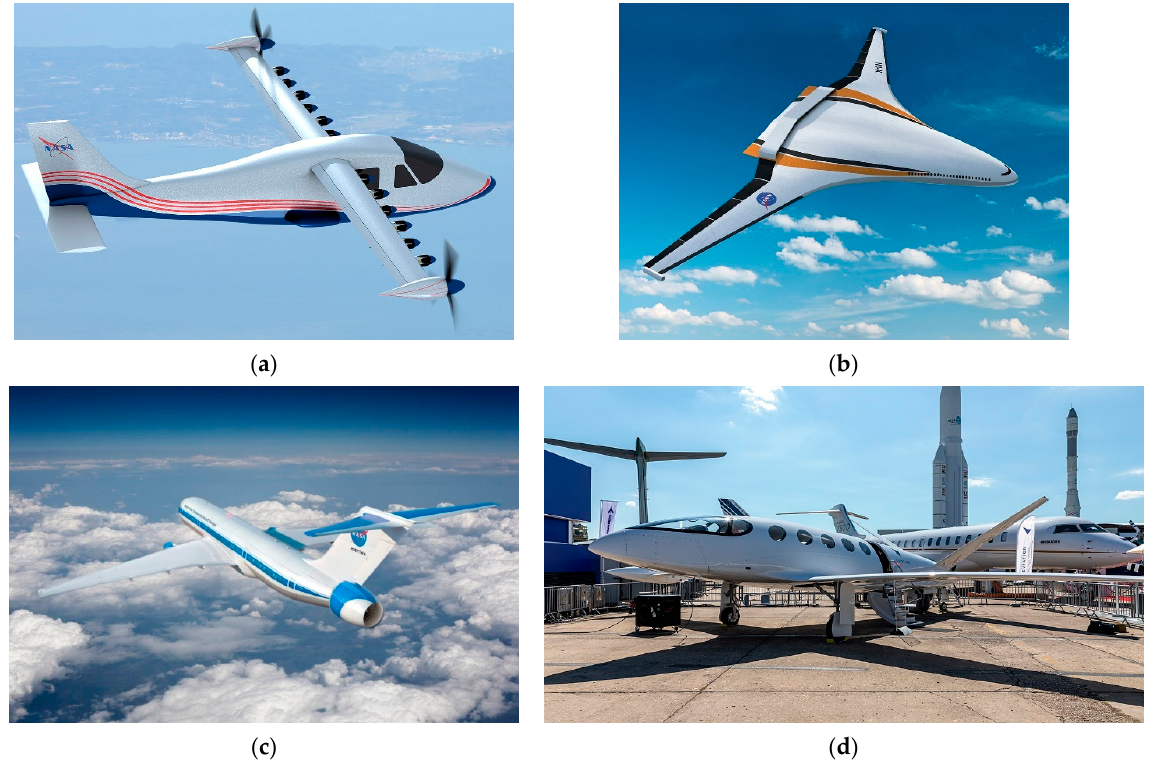
Figure 16. Disruptive configurations using DEP technologies: ( a ) NASA X-57; ( b ) NASA N-X3; ( c ) NASA STARC-ABL; ( d ) Eviation Alice/Matti Blume/CC BY-SA.